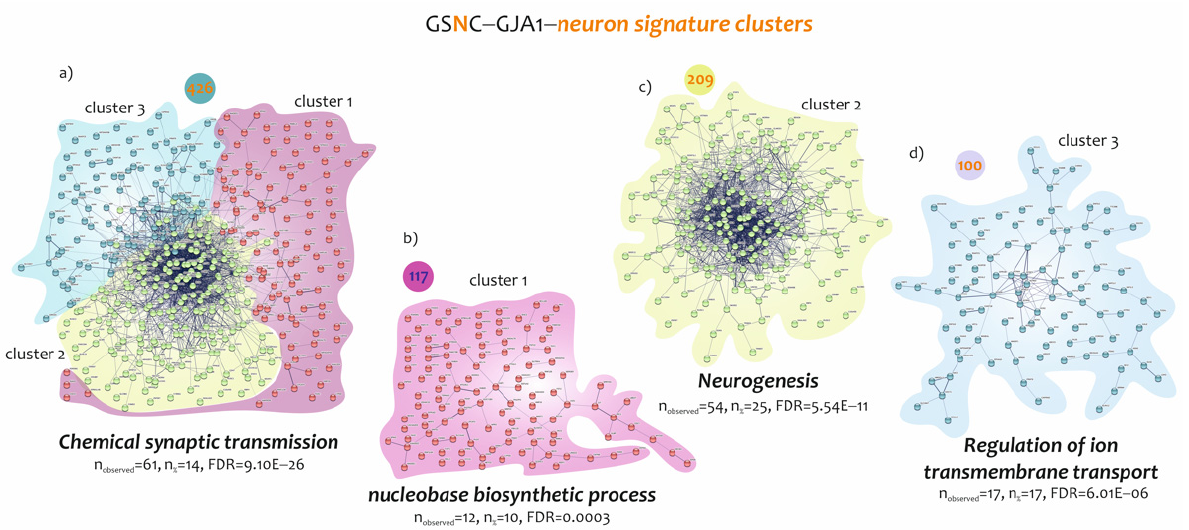
Figure 5. GO analysis of common genes identified by the neuron signatures determined by GJA1 low spinal cord expression levels. ( a ) Fisher t-test analysis showed 426 genes significant in common between neuron–neuro-immune signature and GSNC-GJA1 signature. The main biological process involved in activation of 426 genes was the chemical synaptic transmission (FDR = 9.10E − 26, n = 61). ( b ) Cluster 1 identified by 117 genes with the nucleobase biosynthetic process as the main biological process (FDR = 0.0003, n = 12). ( c ) Cluster 2 identified by 209 genes with the neurogenesis as the main biological process (FDR = 5.54E − 11, n = 54). ( d ) Cluster 3 identified by 100 genes with the regulation of ion transmembrane transport as the main biological process (FDR = 6.01E − 06, n = 17). 3.4. Effect of Drugs Mimicking and Opposing GJA1 Transcriptomic Signatures Obtained from Spinal Cord of ALS Patients Anti-signature perturbation analysis was performed using the GSPC-GJA1 and GSNC- GJA1 signatures identified for ALS patients and uploaded to L1000FWD. Among the predicted drugs, we only highlighted those that are already in clinical use (Table